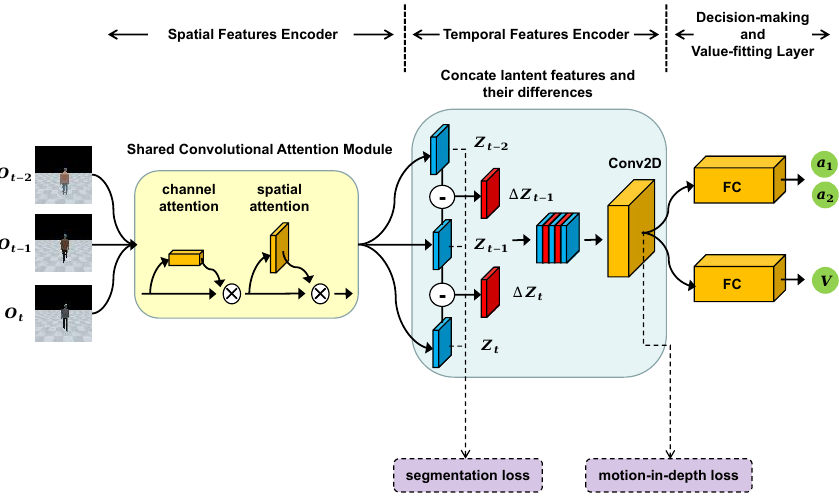
Figure 3. Architecture of the end-to-end perception and high-level decision-making RL